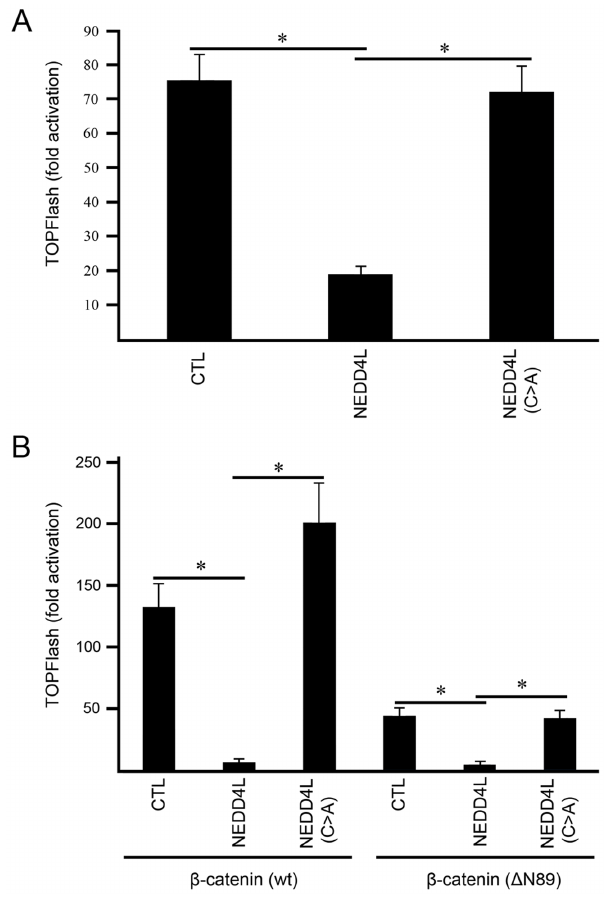
Figure 5. NEDD4L inhibits canonical WNT signaling at or below the level of b -catenin activation. (A) NEDD4L inhibits TOPFlash activity in HEK293 cells compared to empty vector (CTL) or catalytically inactive NEDD4L [NEDD4L (C . A)]. WNT3A (20 ng/ml) and R-spondin (100 ng/ml) were used to activate canonical WNT signaling. (B) When two different b -catenin constructs, b -catenin (wt) and b -catenin ( D N89), are used to activate canonical WNT signaling a significant reduction in TOPFlash activity was observed in the presence of NEDD4L overex- pression, as compared to empty vector or NEDD4L (C . A). All results are normalized to FOPFlash activity. *p ,